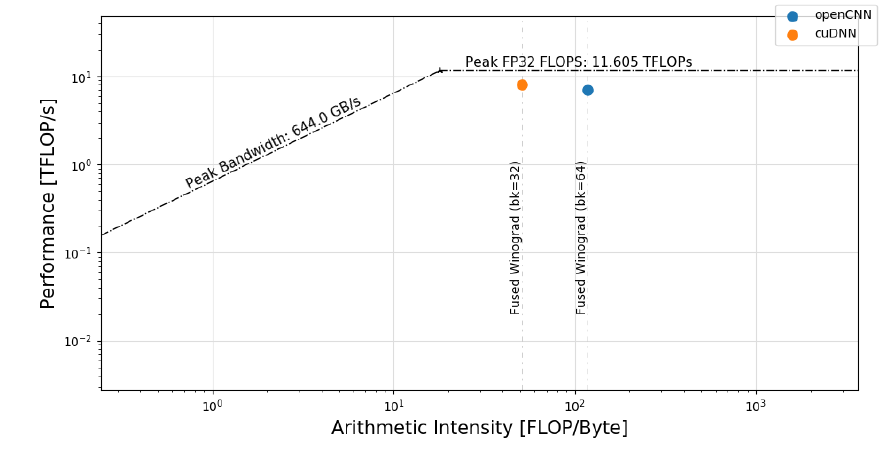
Figure 16. Roofline model of cuDNN and openCNN on the Fused Winograd